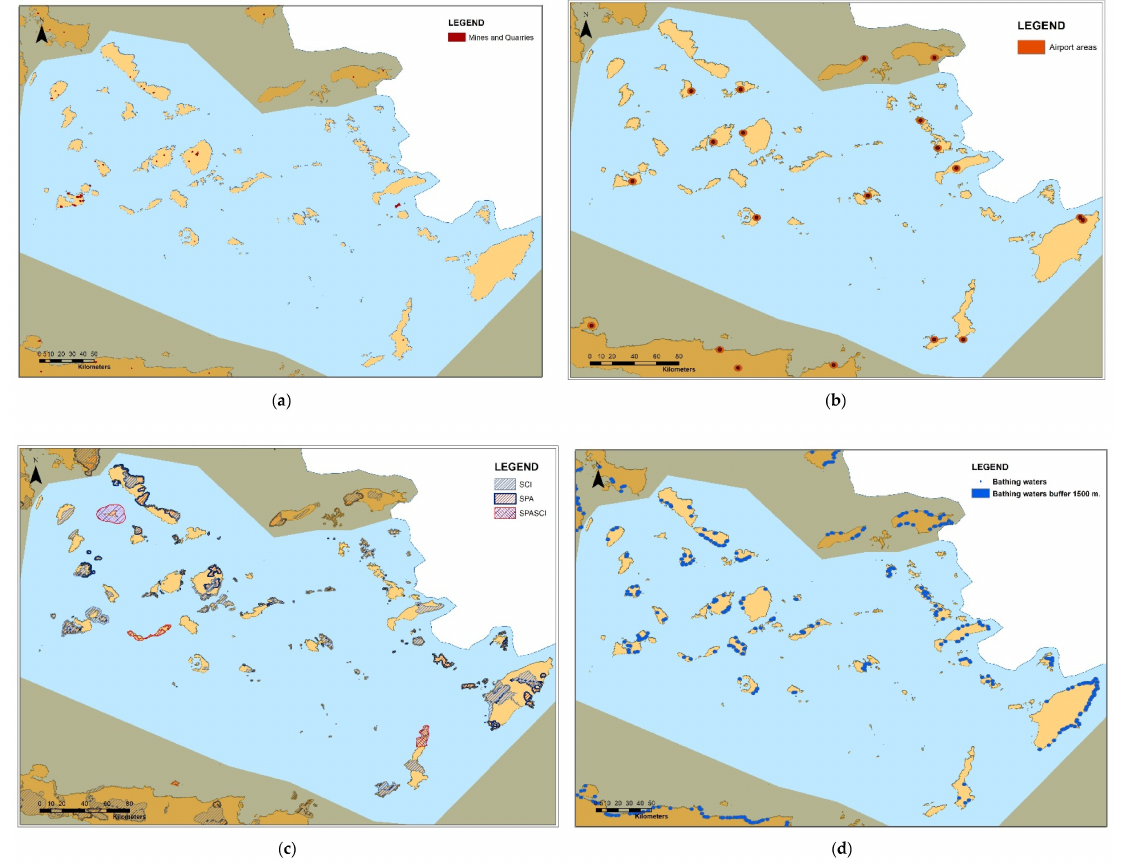
Figure 3. Thematic maps of exclusion criteria related to: ( a ) mines and quarries (EC3), ( b ) airports (EC4), ( c ) Natura 2000 (EC6), and ( d ) bathing